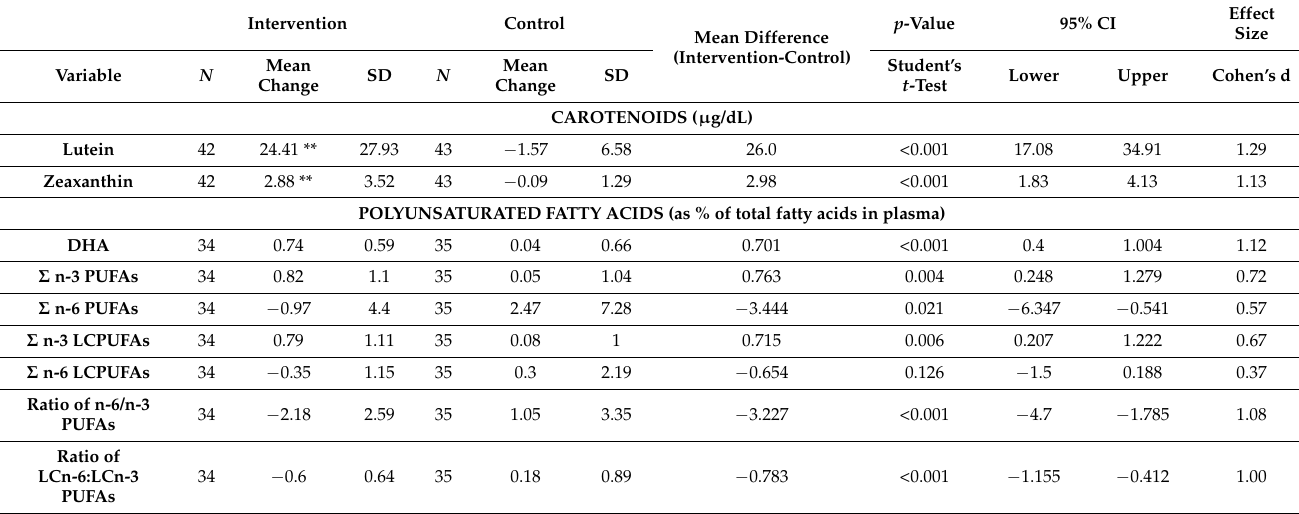
Table 2. Changes in carotenoids and polyunsaturated fatty acids at month